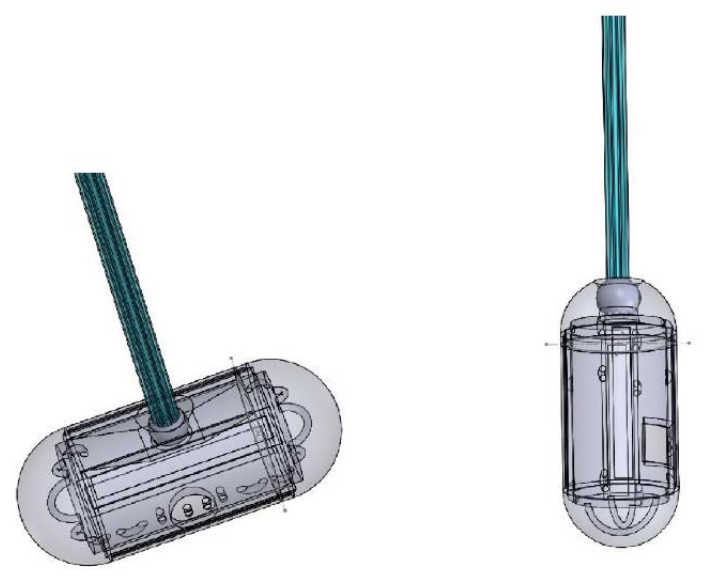
Figure 9. Left : configuration A of the first version. Right : configuration B of the first version.